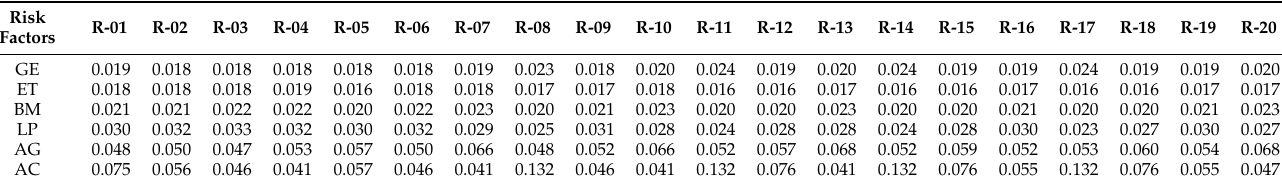
Table 16. Variation in criteria weight due to change in expert’s